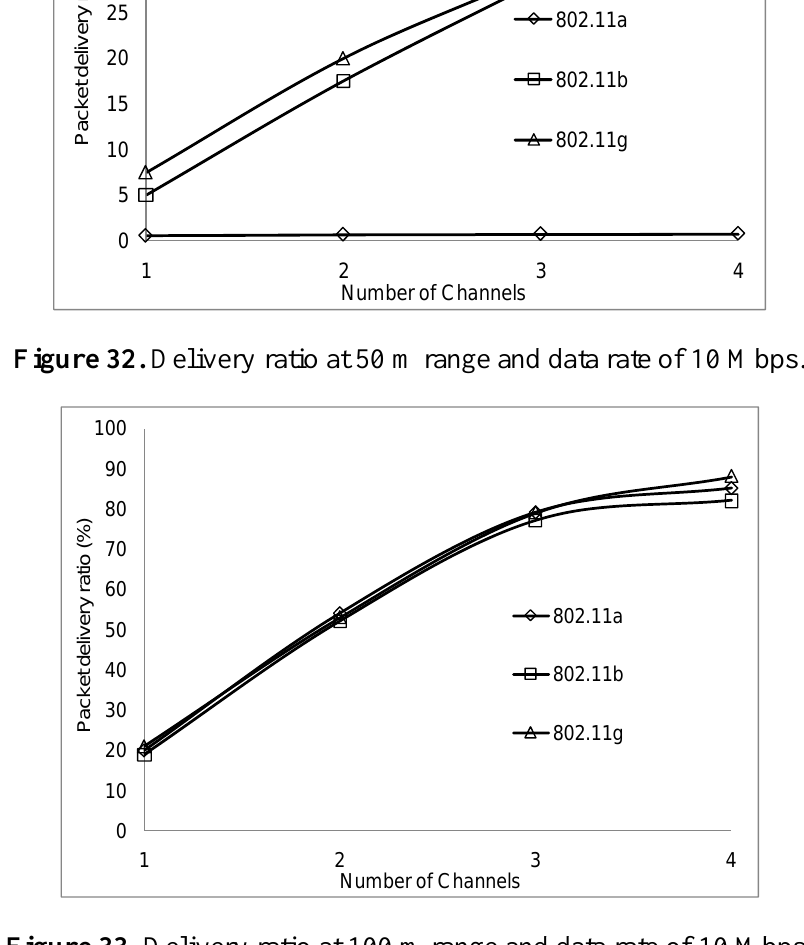
Figure 33. Delivery ratio at 100 m range and data rate of 10